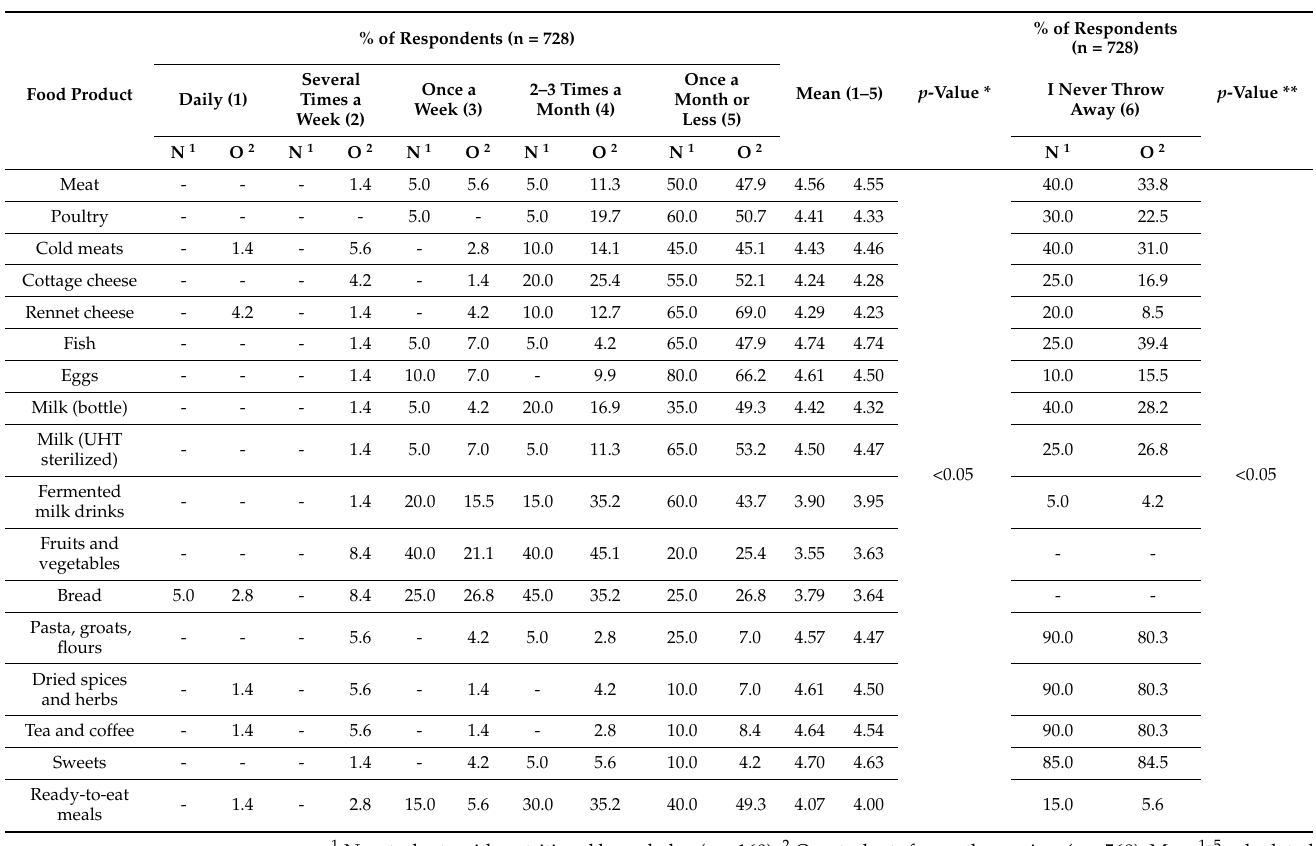
Table 4. Frequency of food discarding among students.